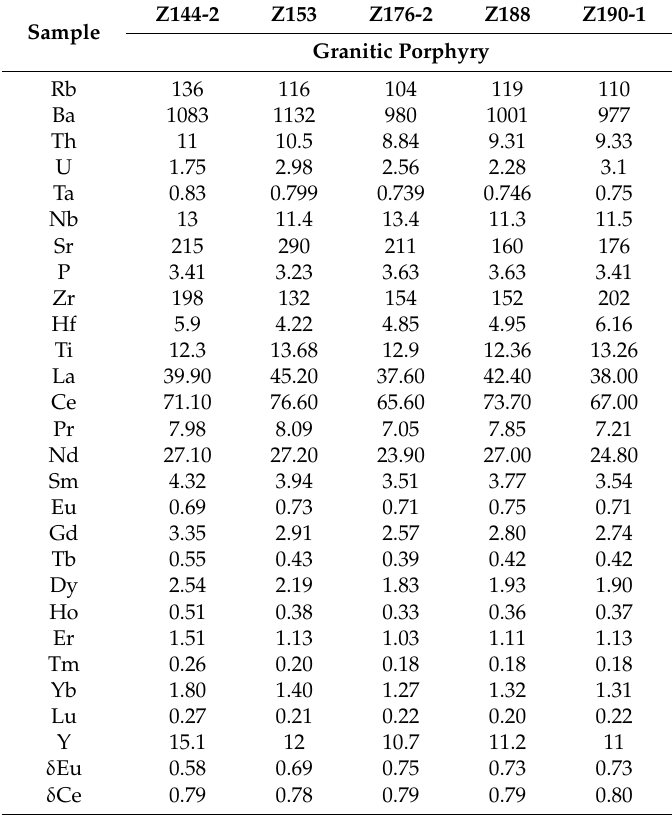
Table 4. Trace element composition of the Xiajinbao granite